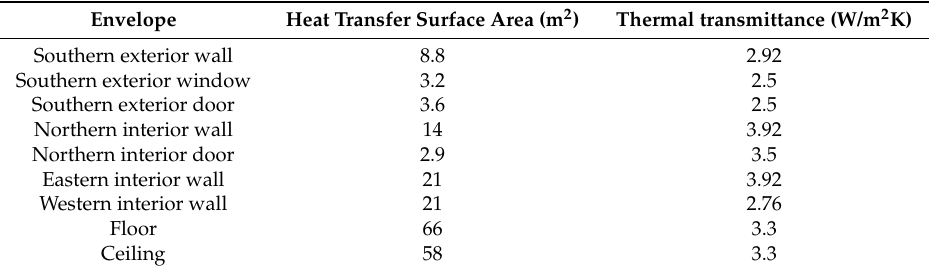
Table 5. The parameters of the building